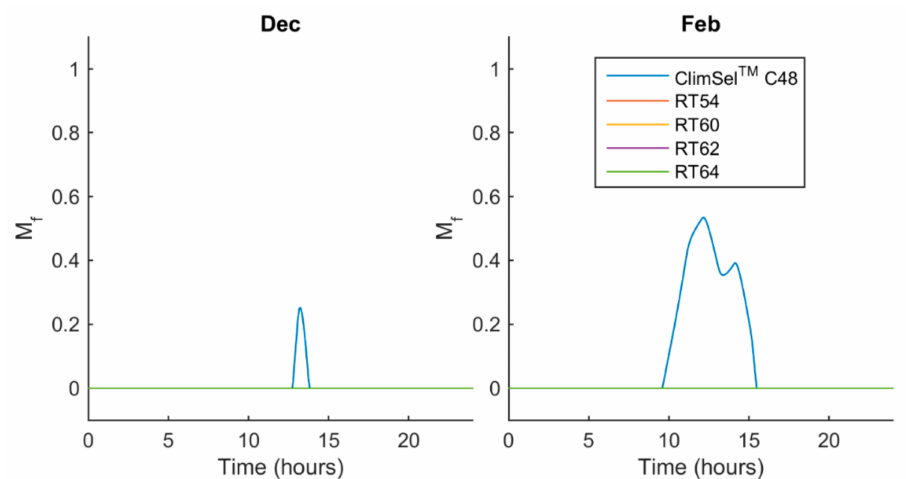
Figure 11. Melt fraction of ClimSel TM C48, RT54, RT60, RT62, and RT64 for the month of December and February.